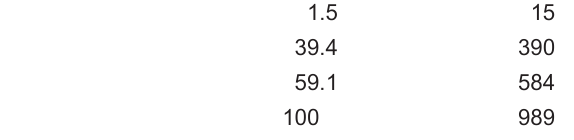
How big of a problem do you think partner violence is among ...